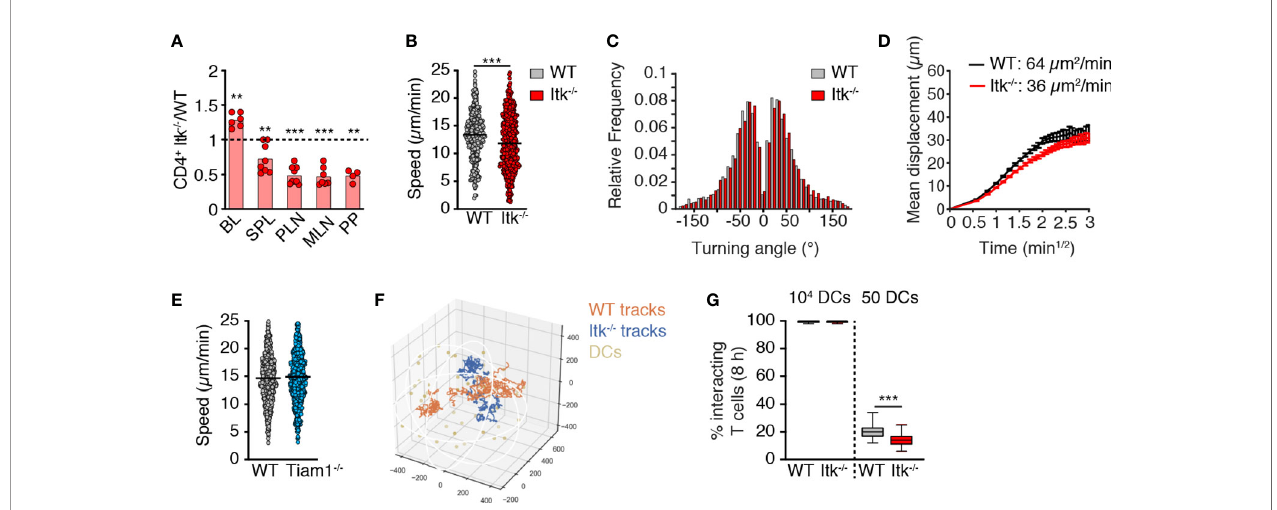
FIGURE 2 | Itk contributes to in vivo T N homing and motility. (A) Ratio of Itk -/- to WT CD4 + T N in blood (BL), spleen (SPL), PLN, mesenteric LN (MLN), and Peyer ’ s patches (PP) at 2 h post adoptive transfer. (B, C) Speeds (B) and frequency of turning angles (C) of WT and Itk -/- CD4 + T N in LN parenchyma. (D) Mean displacement of T cells as a function of the square root of time. (E) Speeds of WT and Tiam1 -/- T N in LN parenchyma. (F) Representative 8-h-long in silic o WT and Itk -/- CD4 + T cell tracks with 50 dispersed DCs. Numbers indicate µm. (G) Percentage of 100 in silico WT and Itk -/- CD4 + T cell tracks encountering 1 in 10 4 or 50 DCs in 50 8-h simulations. All data were pooled from at least two independent experiments (except PP in A; n = 4 mice from one exp.). Data in (A) were analyzed by a one-sample t-test against the theoretical value of “ 1 ” (= equal recovery); data in (B, E, G) were analyzed using an unpaired Student ’ s t-test, and data in (C) using Mann – Whitney test. **p < 0.01; ***p <